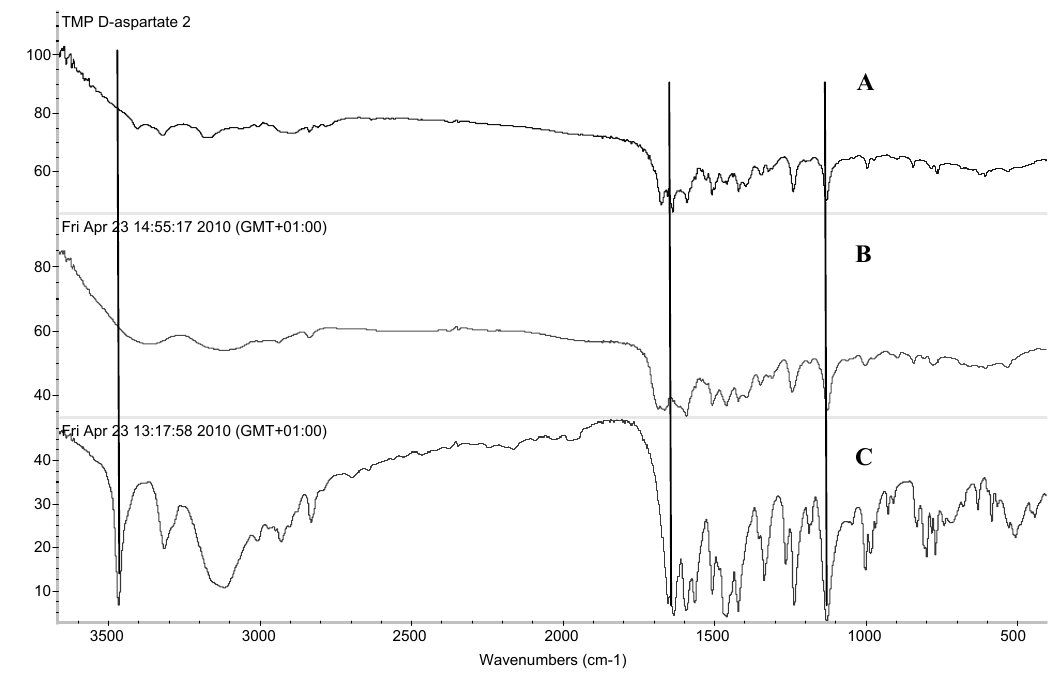
Figure 3. FTIR spectra of (A) trimethoprim D -aspartate, (B) trimethoprim L -aspartate and (C)